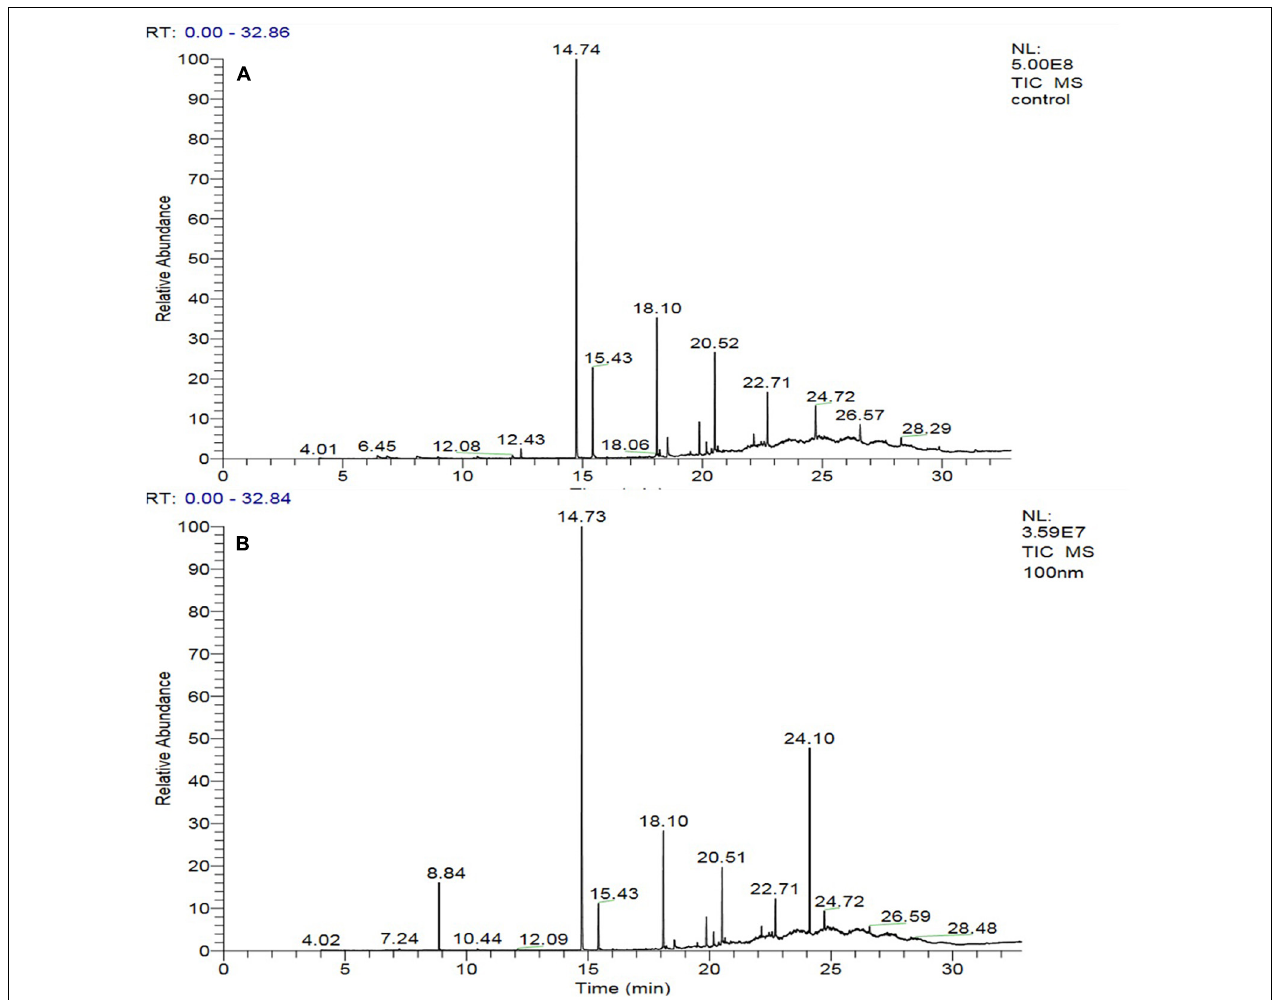
FIGURE 3 | GC-MS chromatogram of crude metabolites of D. longicolla cultures (A) non-treated and (B) 100 nM BRD4770 treated.